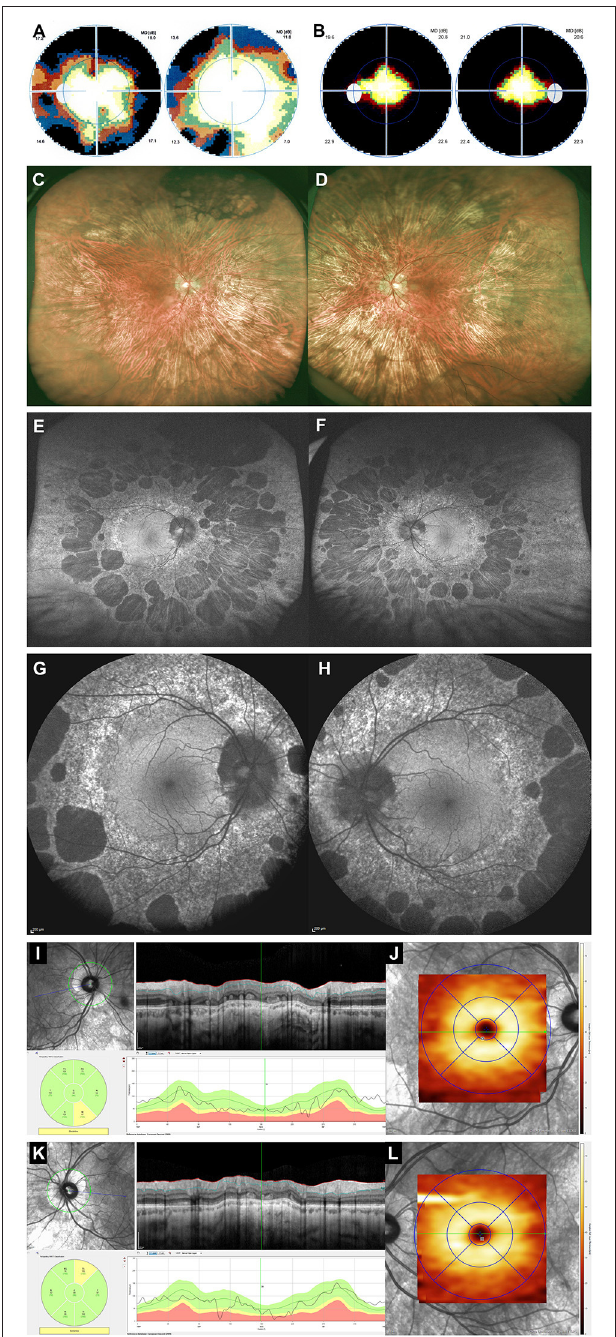
FIGURE 2 | Multimodal imaging of didanosine peripheral retinopathy (patient 2). Top row—Results of computerized static perimetry (Octopus 300, program G1, Haag-Streit AG, Köniz, Switzerland) 5 years earlier (A) and at time of examination (B) revealed progressive peripheral constriction of visual field in both eyes. Second row—Widefield fundus photography (Optos, GmbH, Zweigneiderlassung Zug, Switzerland) showed a 360 ◦ of mid-peripheral areas of chorioretinal atrophy, sometimes coalescent, as well as pigment accumulation mainly in superior retina of both eyes (C,D) . Third row—Widefield autofluorescent photography (Optos, GmbH, Zweigneiderlassung Zug, Switzerland) better delineated shape and size